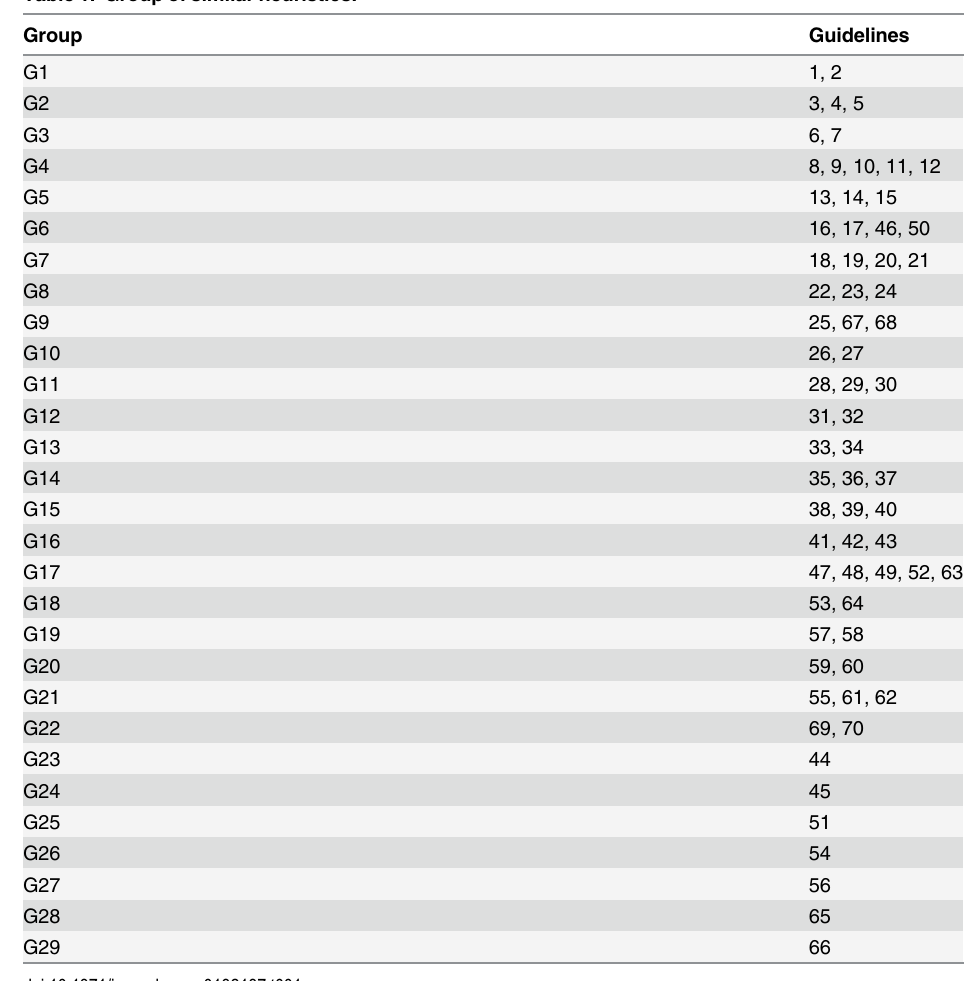
Table 1. Group of similar